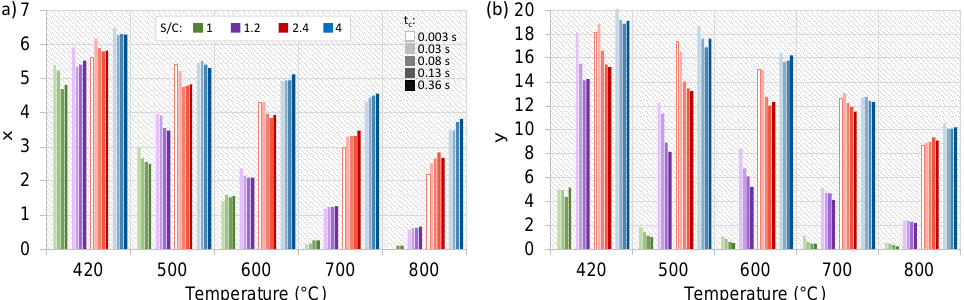
Figure 10. The number of catalytic cycles of the WGS ( a ) and H 2 O dissociation ( b ) reactions during the catalytic tests of toluene steam reforming carried out at S/C = 1 (green), 1.2 (purple), 2.4 (red), and 4 (blue), and contact times (t c ) varying from 0.003 to 0.36 s (the shade of the bar darkens when the t c value increases).